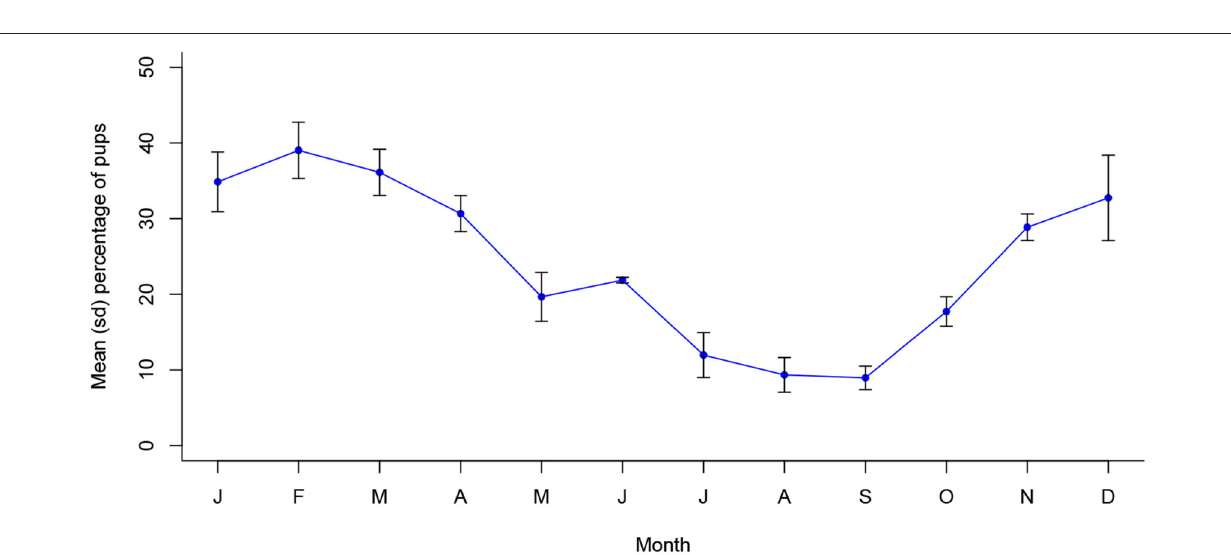
N = 5,750) = 294.07, p < 0.001) was significantly associated